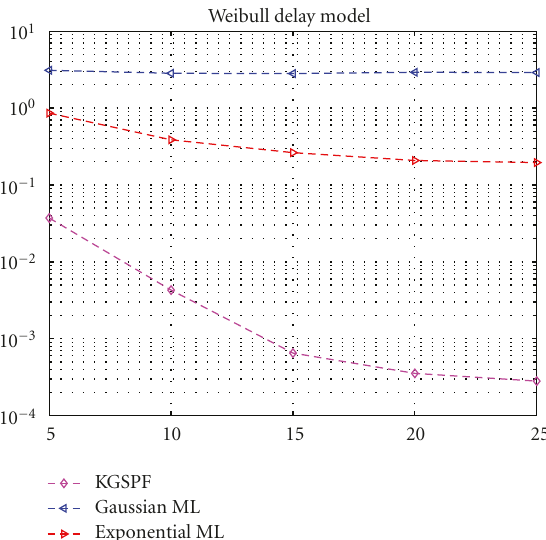
Figure 4: MSEs of clock o ff set estimators for Weibull random delays = 2 and α = 6, β = [ α 1 = 2, β 2 2 1